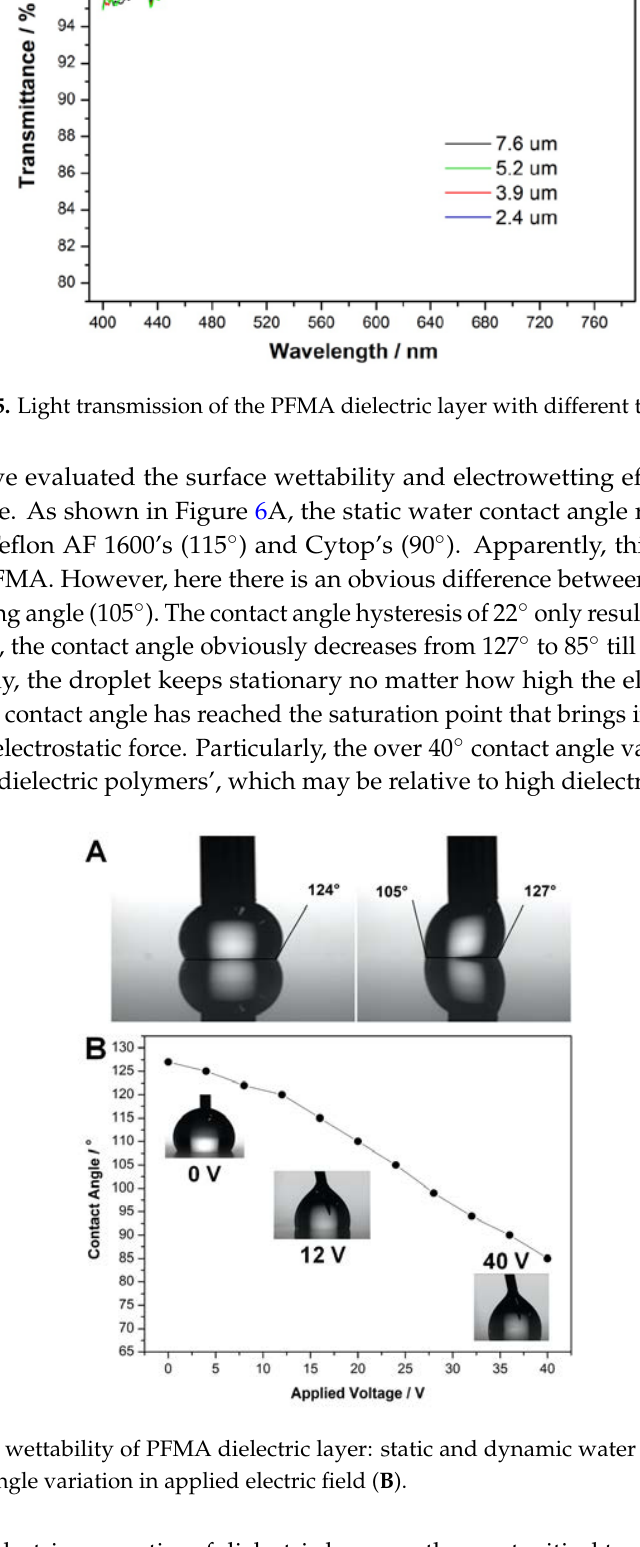
Figure 6. Surface wettability of PFMA dielectric layer: static and dynamic water contact angles ( A ), and the contact angle variation in applied electric field ( B ).